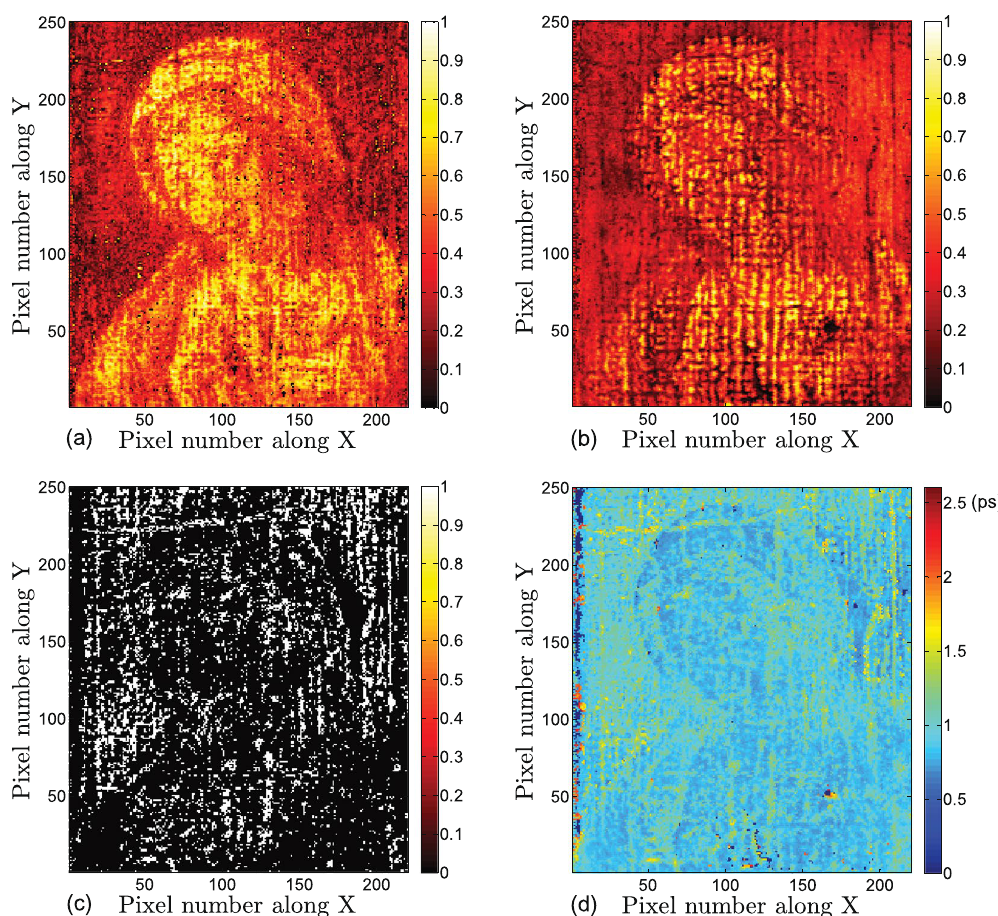
Figure 7. Features of the pictorial layer revealed by THz sparsity-based deconvolved signals. ( a ) THz C-scan based on the amplitude of second peak of the deconvolved signals; ( b ) THz C-scan based on the amplitude of the peak corresponding to the interface between the pictorial and underpainting layers; ( c ) binary THz C-scan indicating the positions where delamination occurs; ( d ) THz C-scan based on the optical delay between the peaks corresponding to the thickness of the pictorial